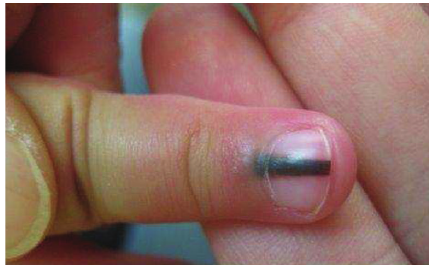
Figure 8: Pseudo-Hutchinson’s sign in a nail apparatus nevus.